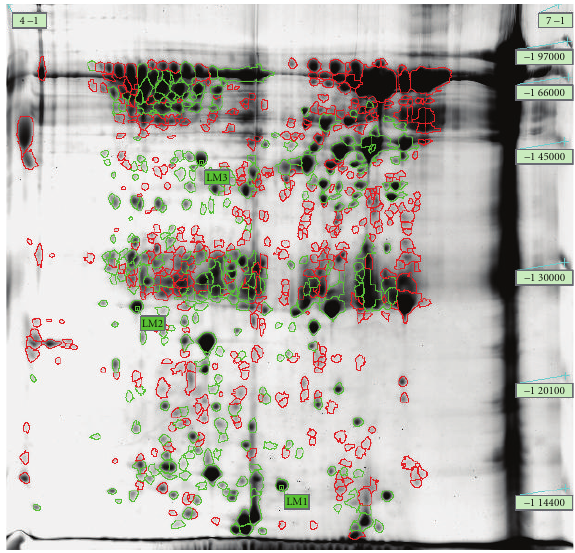
Figure 3: Analysis of 2DE protein matching after the formation of lung cancer (pH 4–7). The green spots were the matched protein spots and the red spots were the unmatched, the number of matched proteins was